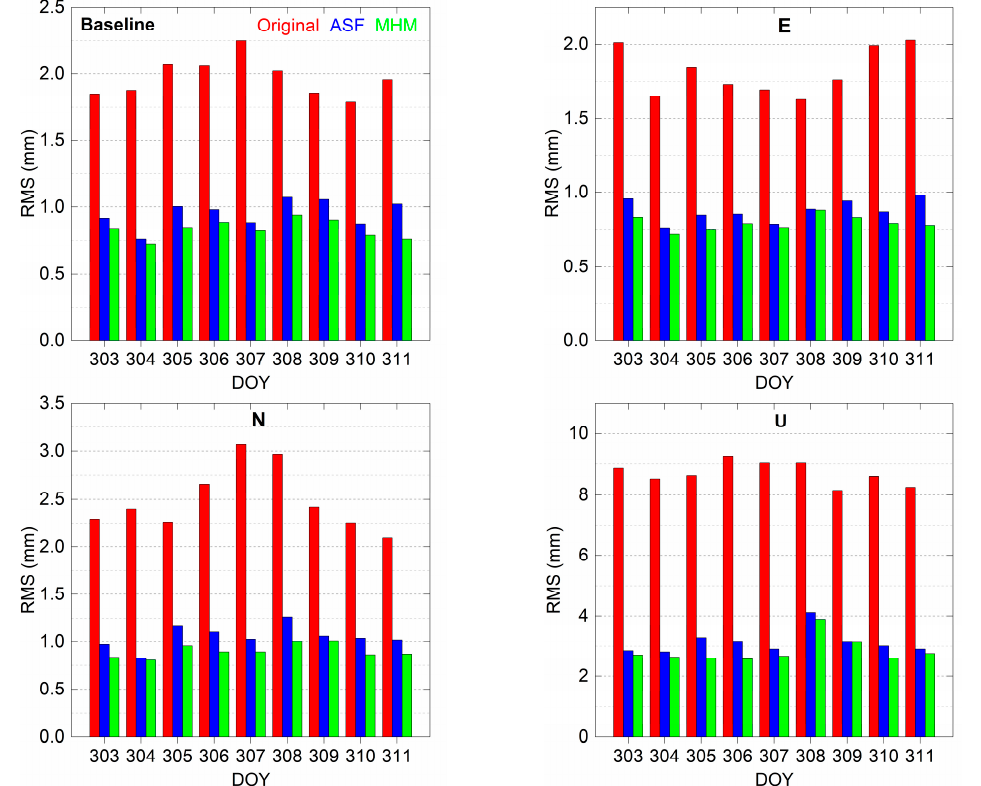
Figure 11. The nine-day positioning accuracy in the east, north, and vertical directions and the baseline accuracy.